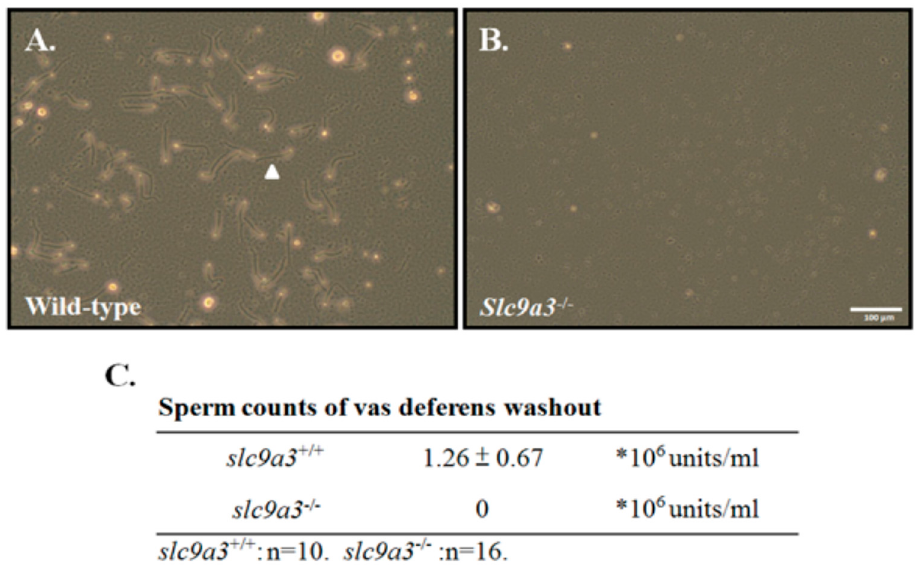
Figure 6. Sperm counts of vas deferens washout from Slc9a3 knockout mice. Sperm were isolated from the vas deferens of ( A ) wild-type and ( B ) Slc9a3 knockout mice. Arrowhead indicates mature sperm. Scale bar = 100 µ m; ( C ) Sperm counts from Slc9a3 +/+ ( n = 10) and Slc9a3 − / − ( n = 16) mice.